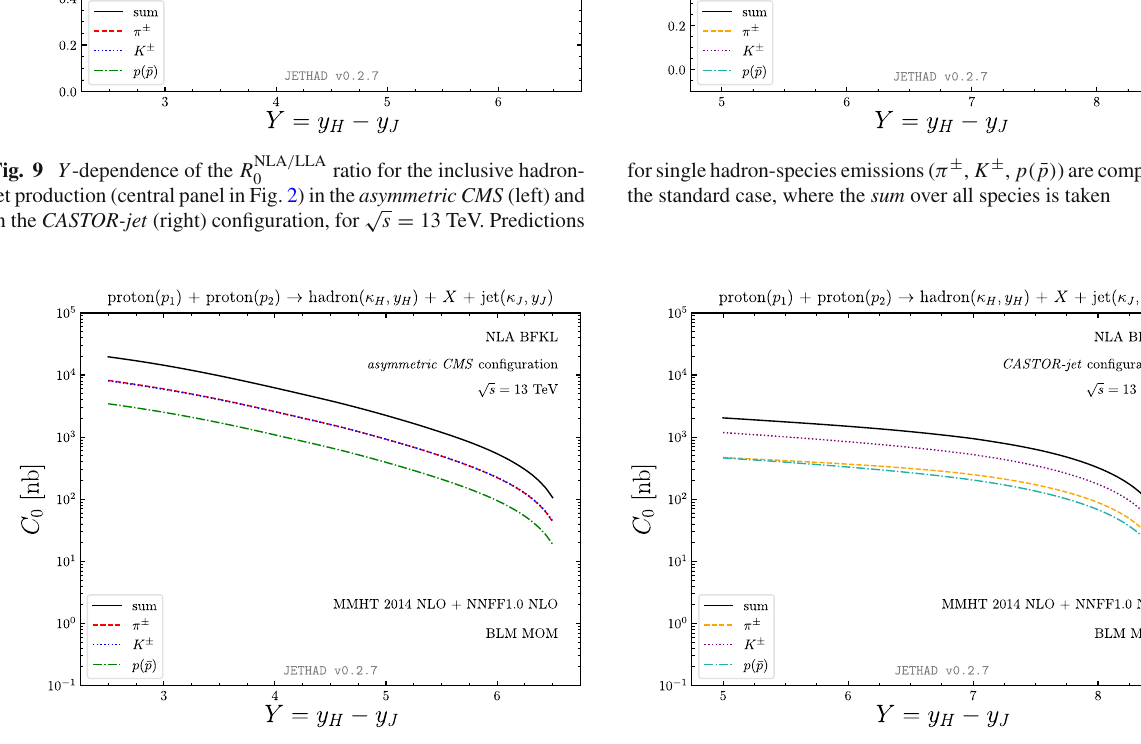
Fig. 10 Y -dependence of the ϕ -averaged cross section, C 0 , for inclu- sive hadron-jet production (central panel in Fig. 2) in the NLA BFKL accuracy, in the asymmetric CMS (left) and in the CASTOR-jet (right)